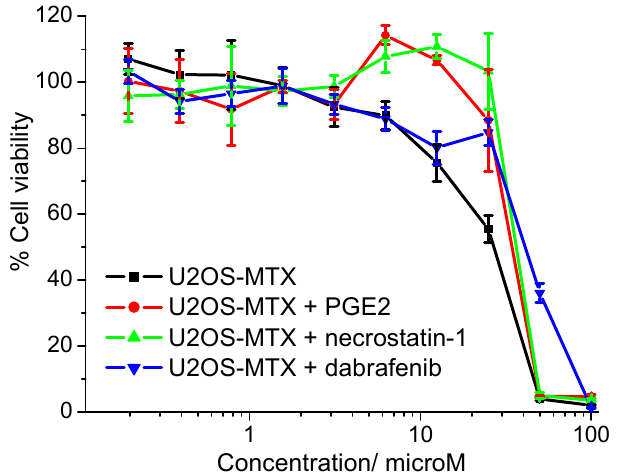
Figure 4. Representative dose-response curves for the treatment of U2OS-MTX cells with 1 in the absence and presence of PGE2 (20 µM), necrostatin-1 (20 µM), or dabrafenib (10 µM) after 72 h incubation.